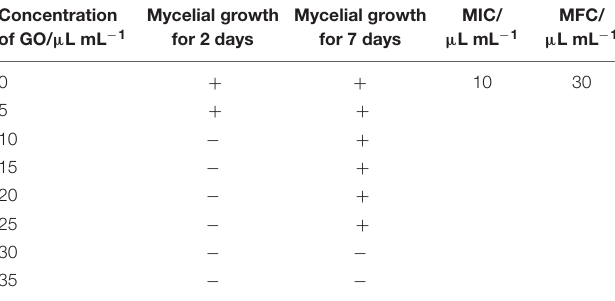
TABLE 1 | Results of minimal inhibitory concentration (MIC) and minimal fungicidal concentration (MFC) of GO for P. microspora